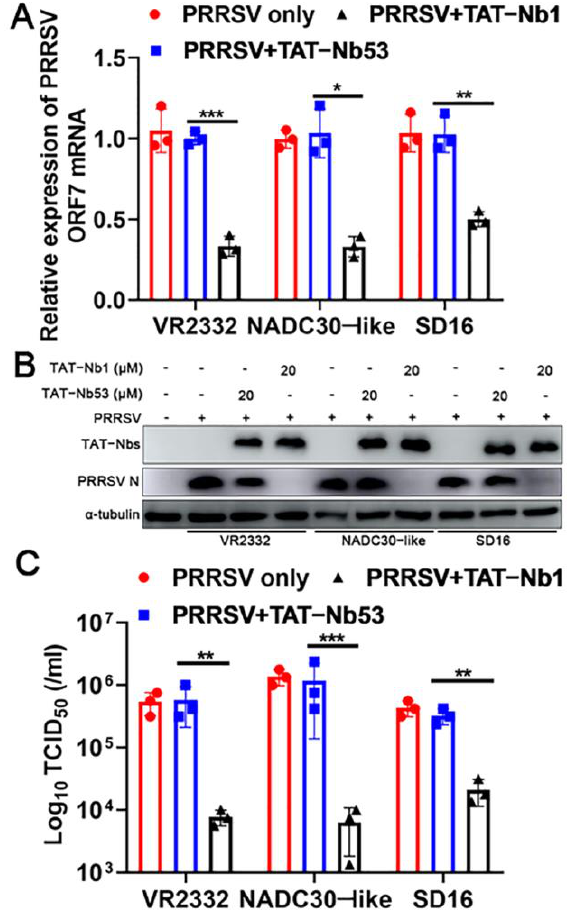
Figure 7. TAT - Nb1 inhibits PRRSV replication independently of viral strains. Marc - 145 cells were seeded in 6 - well plates at a density of 2 × 10 5 cells/well. Then, 24 h later, cells were treated with 20 μM TAT - Nb1 or - Nb53 for 6 h and then infected with VR2332 - , NADC30 - like - , and SD16 - PRRSV at an MOI of 0.1. Cells or supernatants were harvested at 24 hpi to determine the expression of PRRSV ORF7 and N protein using qPCR ( A ), Western blot ( B ), and the supernatant viral titers analysis using TCID 50 ( C ), respectively. α - Tubulin was detected simultaneously as an internal control. Data are expressed as the means ± standard deviations (SD) of the results of three independent experiments. P values were calculated using Student’s t test. * , P < 0.05; ** , P < 0.01; *** , P < 0.001.